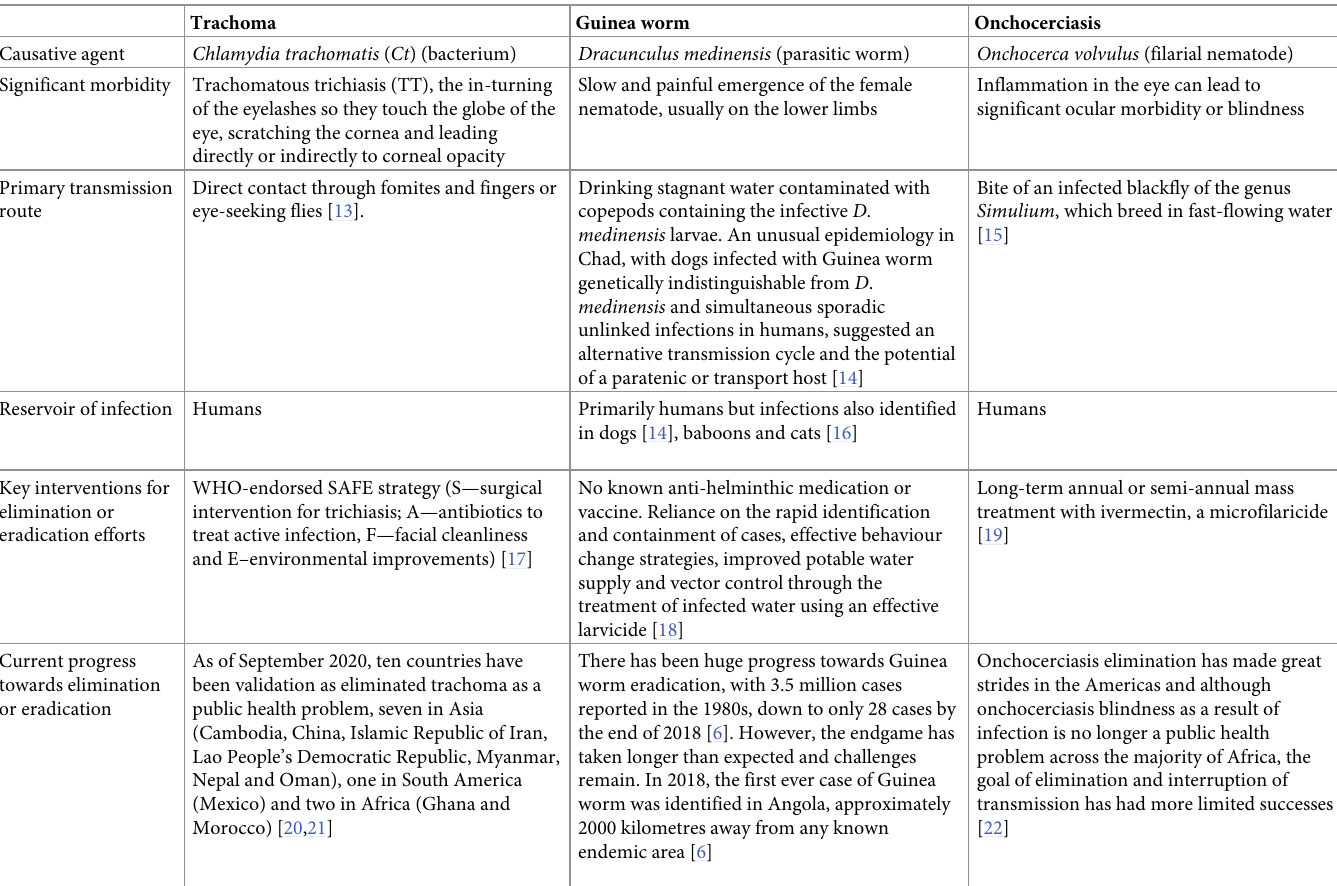
Table 1. A summary of the disease profiles and current interventions for trachoma, Guinea worm and